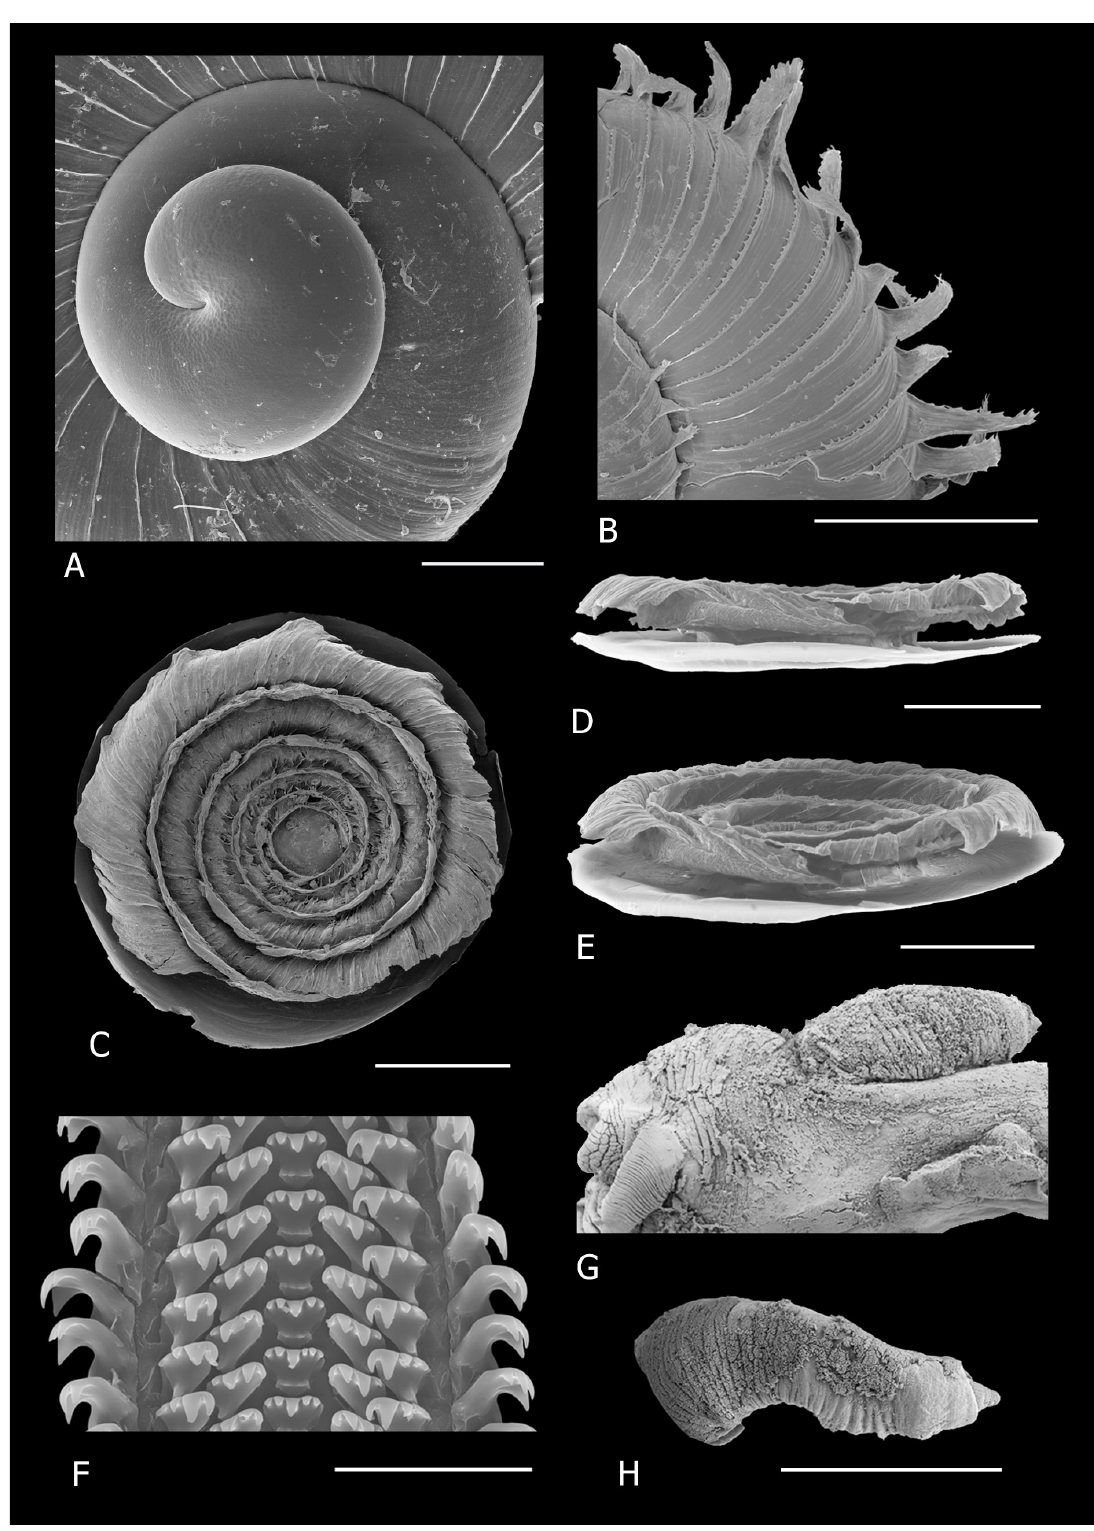
Fig. 7. Chondrocyclus alabastris (Craven, 1880). A . Protoconch (ELM D16888). B . Detail of axial lamellae of periostracum (ELM W3639). C–E . Operculum (ELM W3640). F . Portion of radula (ELM W3640). G . Penis, lateral view, showing position (ELM W3638). H . Penis, dorsal view (ELM W3642). Scale bars: A = 200 µm; B, G–H = 1 mm; C–E = 500 µm; F = 50